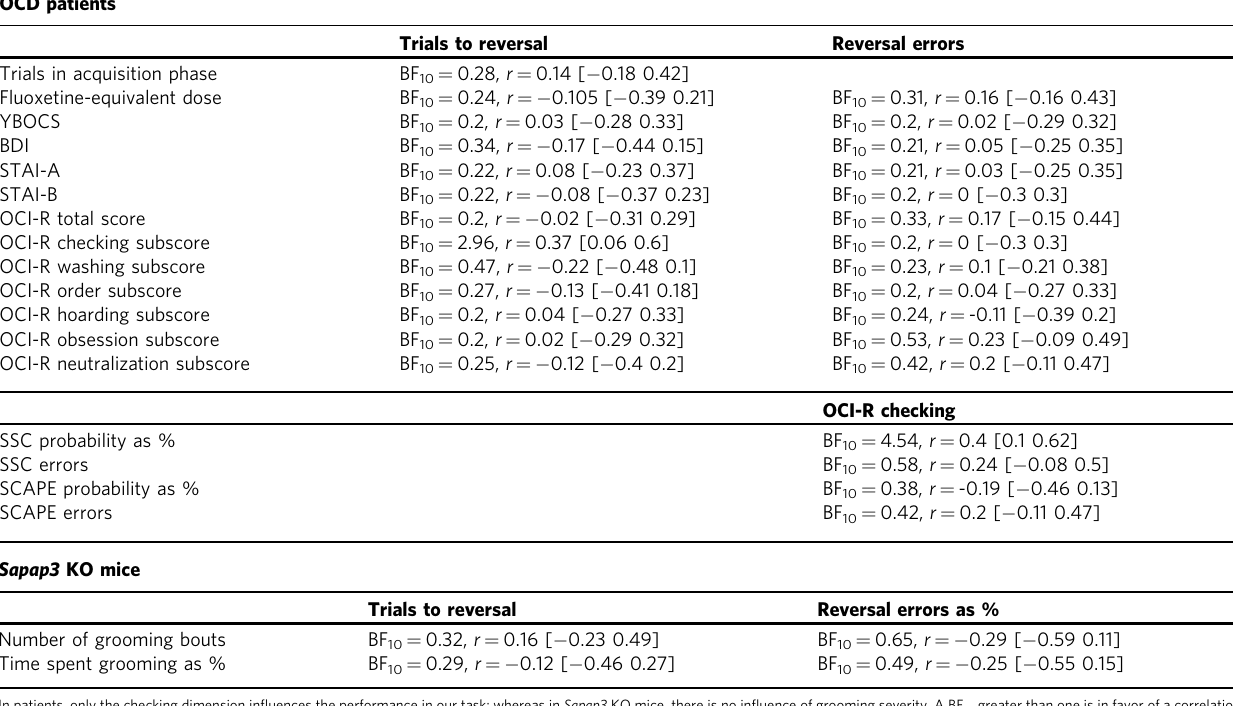
Table 2 Correlation scores between clinical and task